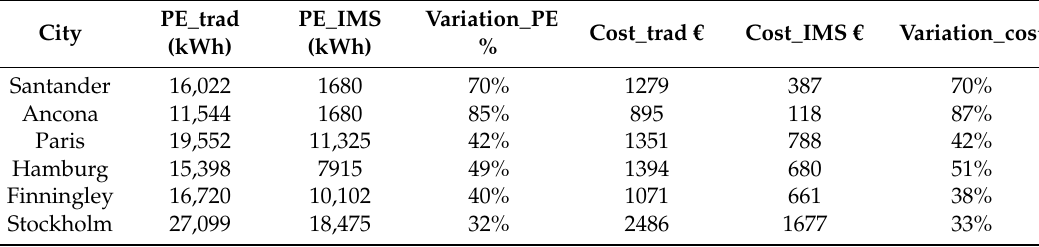
Table 8. Primary energy (PE) savings and operational cost savings of the Innova MicroSolar (IMS) plant coupled with one single dwelling compared to traditional technologies (trad).